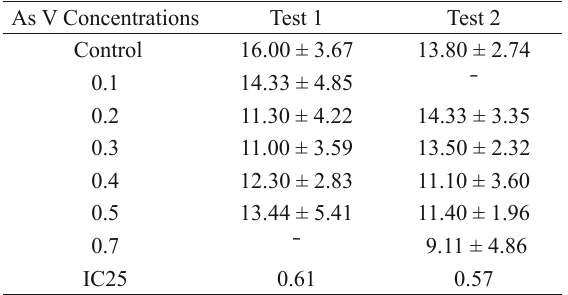
Mean values (n = 10) and standard deviations of neonates in two tests carried out at different concentrations of As V (mg L -1 ) and their corresponding IC25